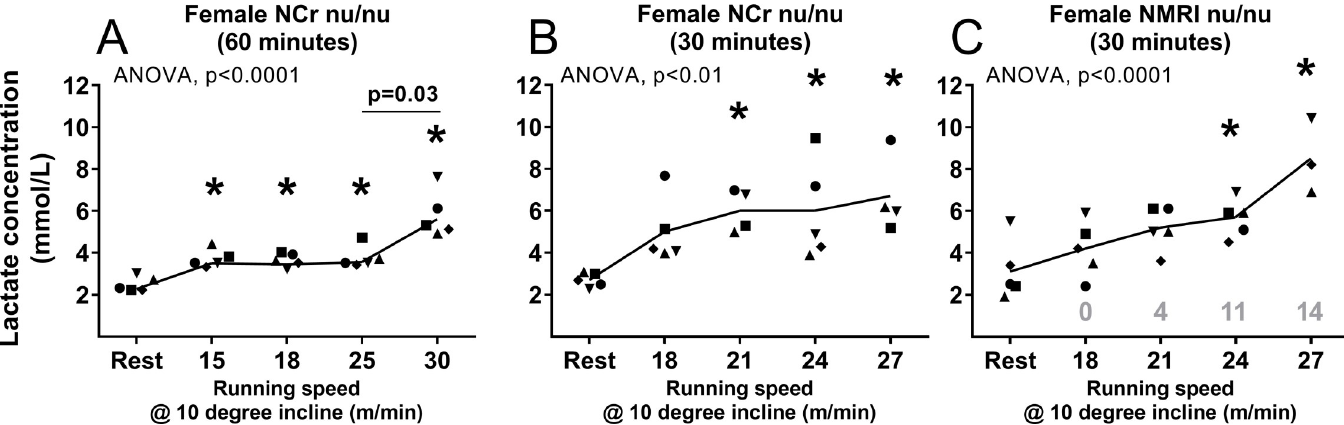
Fig 1. Blood lactate concentration (mmol/L) during rest and immediately post-exercise at increasing running speeds (m/min) in female nude NCr nu/nu mice (n = 5) at a 10-degree incline after 60 minutes of running (1A) ; after 30 minutes of running in female NCr nu/nu mice (1B) and after 30 minutes of running in female nude NMRI mice (1C) . Points represent individual mice. 1A and 1B involved the use of air puffs to encourage mice to run, whereas 1C involved gentle prodding and physical handling. Statistical change (one-way ANOVA, p-value) in lactate concentration with increasing speed is displayed in each Fig. � indicates significant difference compared to the resting value (Student´s t-test, p < 0.05). Specific p-value above line indicates significant difference compared to value at the previous running speed (Students t-test, p < 0.05). If applicable, the mean number of times paced are reported above the x-axis.